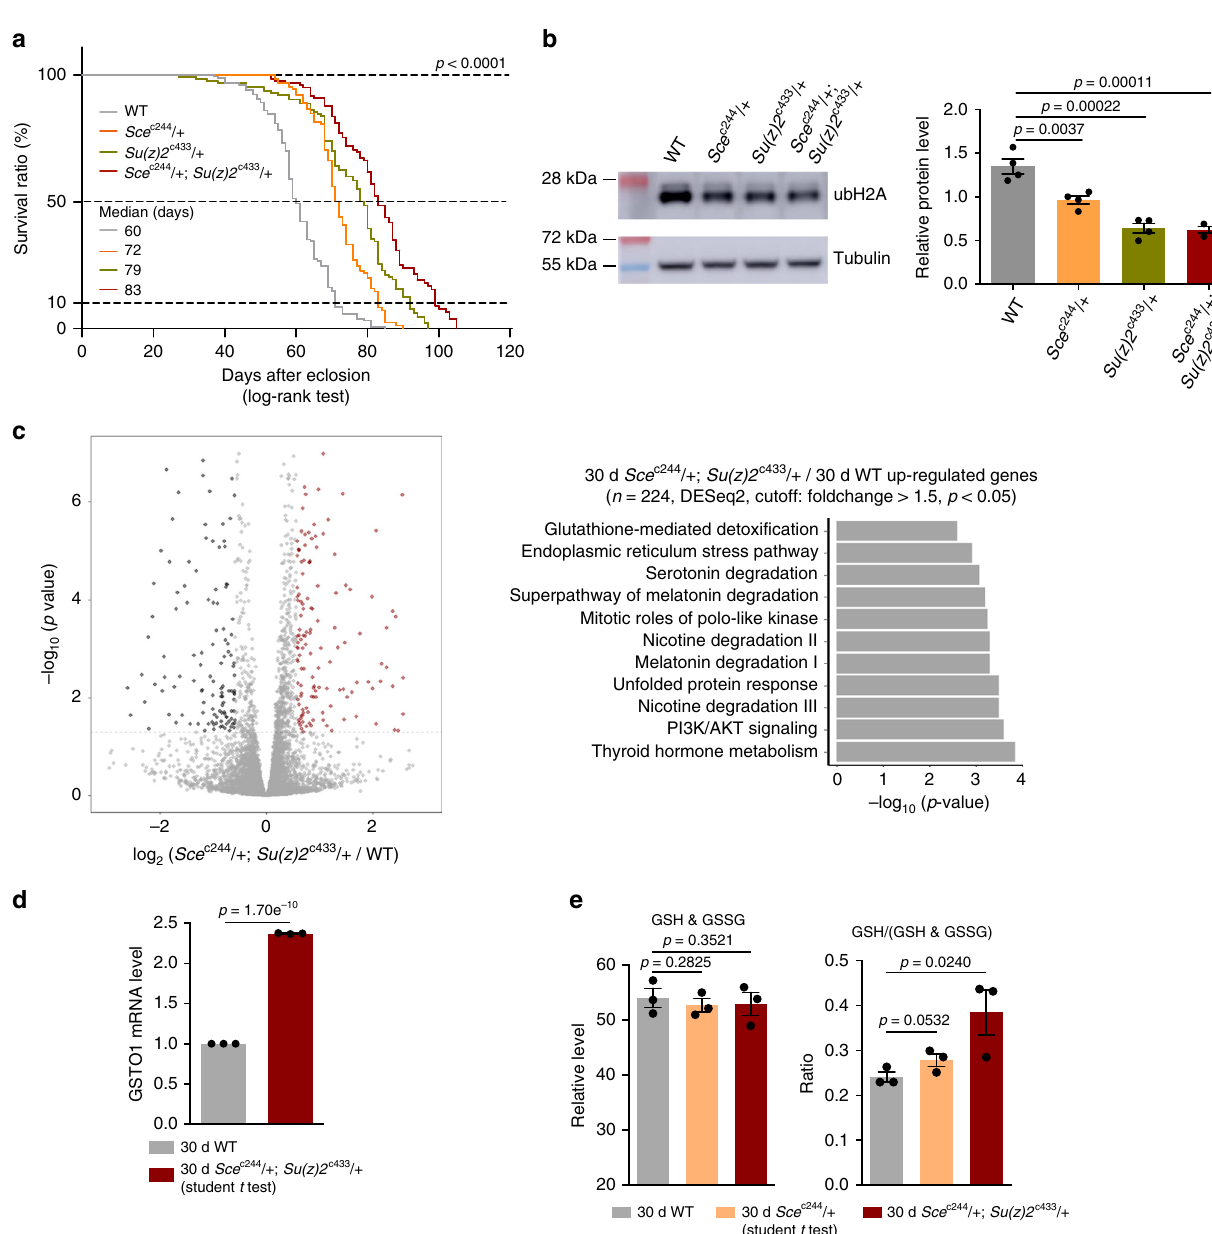
Fig. 4 Reducing ubH2A couples with extended adult lifespan in Drosophila . a Sce c244 / + or Su(z)2 c433 / + single mutants and Sce c244 / + ; Su(z)2 c433 / + double mutants have extended lifespan. All lifespan data of this study were acquired in at least two replicates. (For lifespan: 25 °C; n > 100 male fl ies per genotype for curve; log-rank test). Genotypes ( fl y total number (death / censored)): WT: 5905 (156 (154 / 2)). Sc e c244 / + (128 (113 / 15)). Su(z)2 c433 / + (126 (111 / 15)). Sc e c244 / + ; Su(z)2 c433 / + (144 (103 / 41)). b ubH2A is signi fi cantly decreased in Sce c244 / + , Su(z)2 c433 / + , and Sc e c244 / + ; Su(z) 2 c433 / + fl ies ( n = 4 independent biological repeats for ubH2A quanti fi cation) (mean ± s.e.m.; student t test). Protein was from head tissues of 30d old male heads. c Volcano plot shows that genes are differentially expressed in Sce c244 / + ; Su(z)2 c433 / + double mutants compared to WT (left panel). Differential expression analysis was performed by DESeq2 from 3 biological replicates. 224 genes were found to be upregulated (Fold change > 1.5, p < 0.05). Ingenuity pathway analysis (right panel) shows that “ glutathione-mediated detoxi fi cation ” was signi fi cantly enriched for genes upregulated in the Sce c244 / + ; Su(z)2 c433 / + double mutant ( p = 0.0026, Fisher ’ s exact test). RNA-seq was from heads of 30d old male fl ies. Genotypes: WT: 5905. Sce c244 / + ; Su(z)2 c433 / + . d qRT-PCR analysis shows that GSTO1 of the glutathione-mediated detoxi fi cation pathway becomes signi fi cantly increased in the Sce c244 / + ; Su(z)2 c433 / + double mutants ( n = 3 independent biological repeats for qRT-PCR) (mean ± s.e.m.; student t test). qRT-RNA was from heads of 30d old male fl ies. Genotypes as in c . e While GSH and GSSG levels remain unchanged (left panel), GSH/(GSH + GSSG) ratio (right panel), indicator of the cellular redox level, is higher in Sce c244 / + single mutants and Sce c244 / + ; Su(z)2 c433 / + double mutants than age-matched WT. Metabolic analysis was from heads of 30d old male fl ies. Genotypes: WT: 5905. Sce c244 / + . Sce c244 / + ; Su(z)2 c433 / + ( n = 3 independent biological repeats; student t